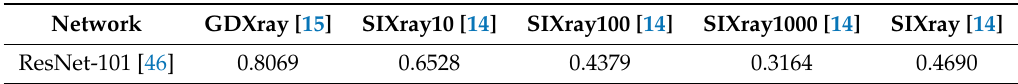
Table 7. Detection performance of a zero-shot classifier (in terms of mAP ) driven through the generalized edge suppression backbone.